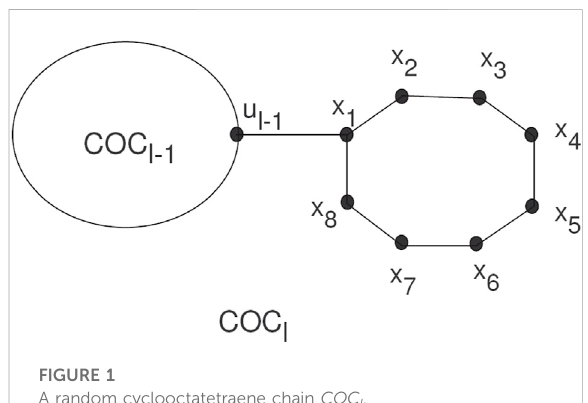
FIGURE 1 A random cyclooctatetraene chain COC l .